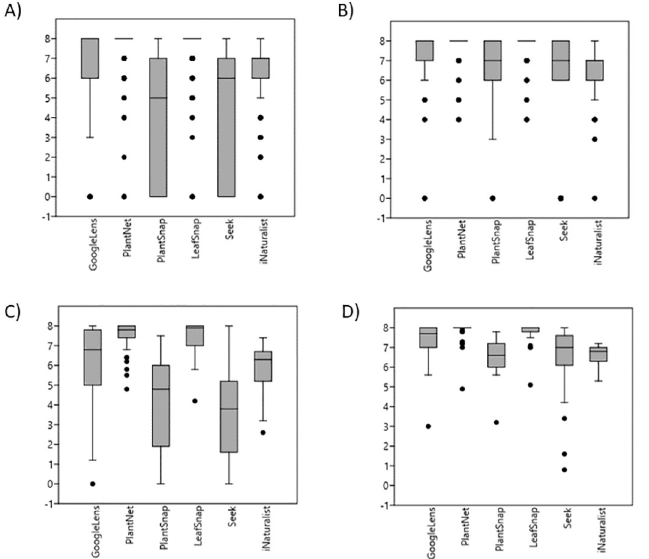
Fig 1. Leaf and flower scores across the entire data set for each plant ID app using scoring system A. (A) Leaf raw data scores (e.g. each individual score per photograph is included) N = 280 (B) Flower raw data scores N = 280 (C) Leaf Average Scores (one score averaged across all photographs per species) N = 38 (D) Flower Average Scores N =